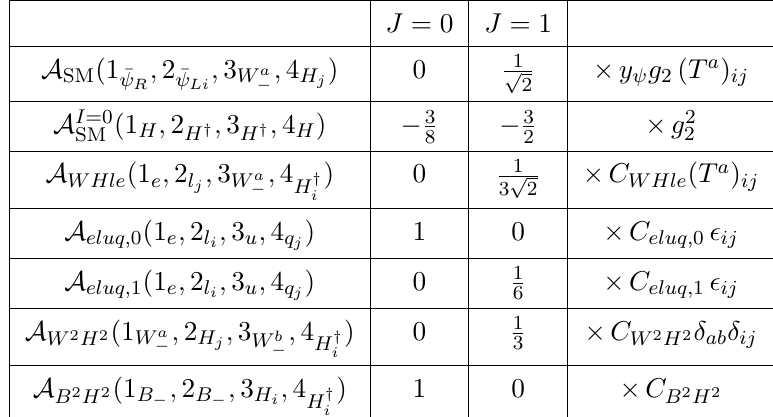
we give the regularized SM